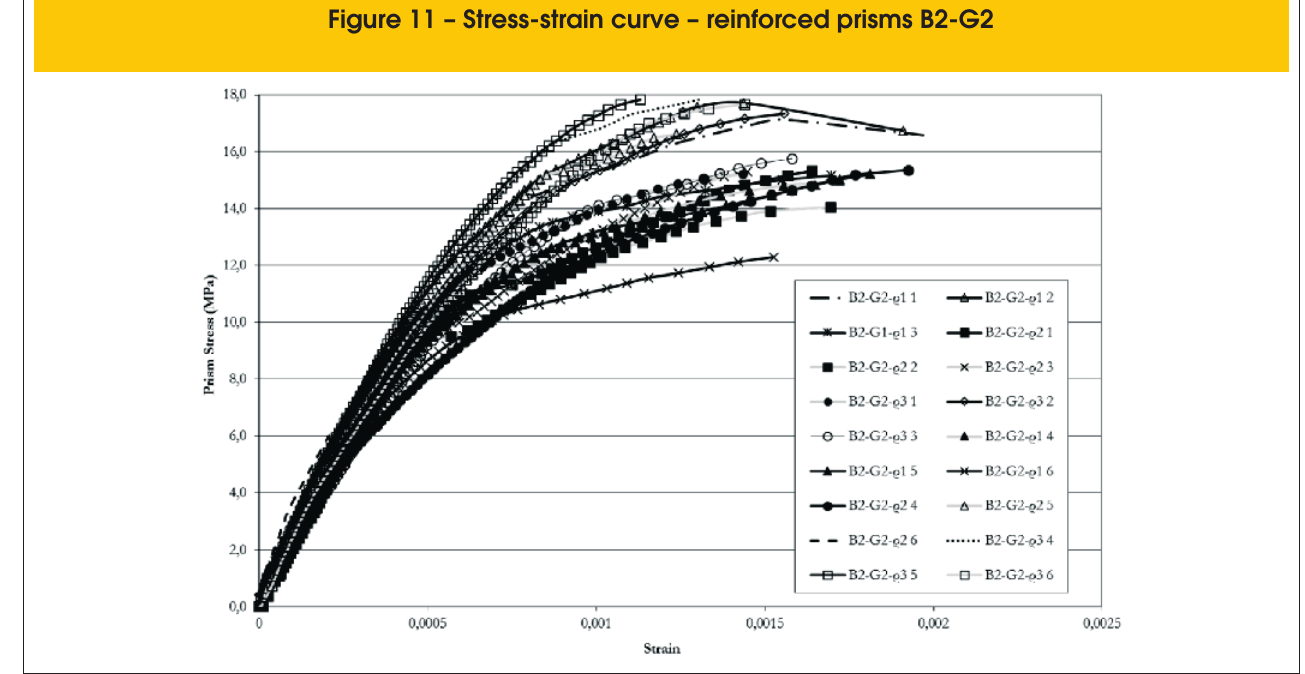
Figure 11 – Stress-strain curve – reinforced prisms